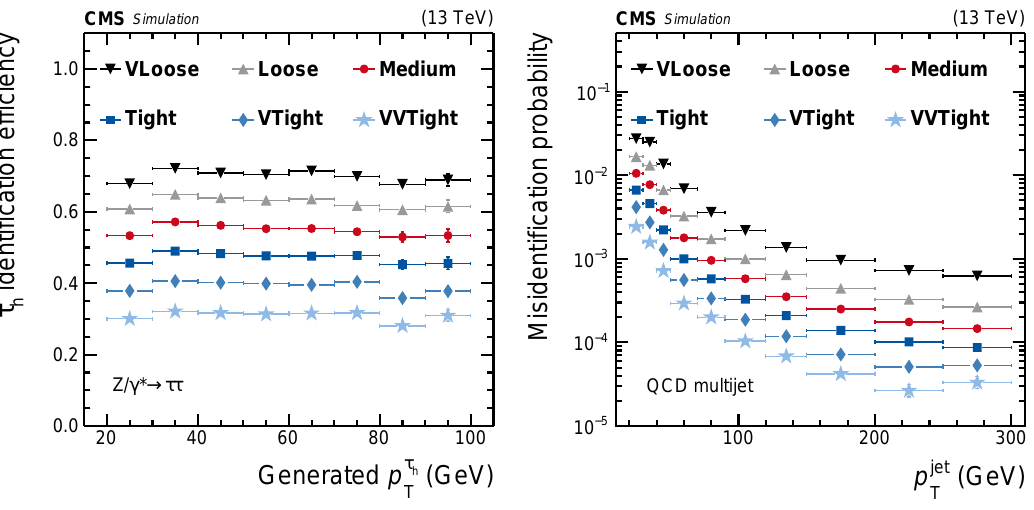
p in Z /γ ∗ → ττ events h T